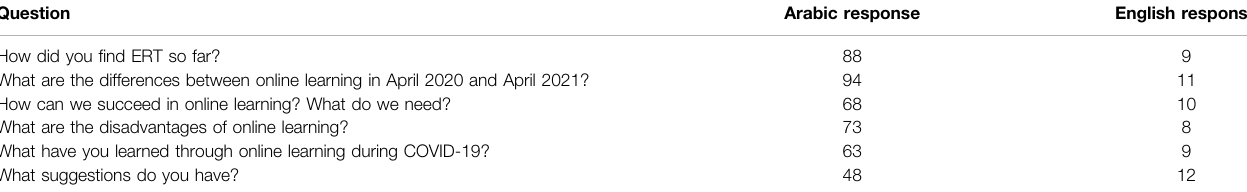
TABLE 3 | The questions and responses of the third re fl ective round on April 2021.